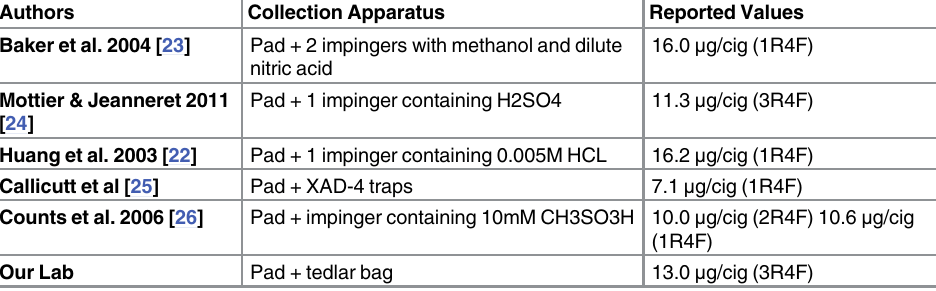
Table 3. Comparison of 3R4F values to those reported in